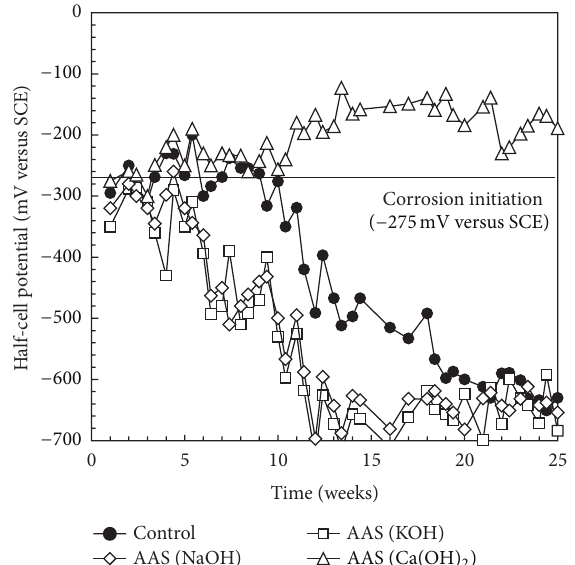
Figure 8: Monitoring of half-cell potential of steel in AAS mortar.